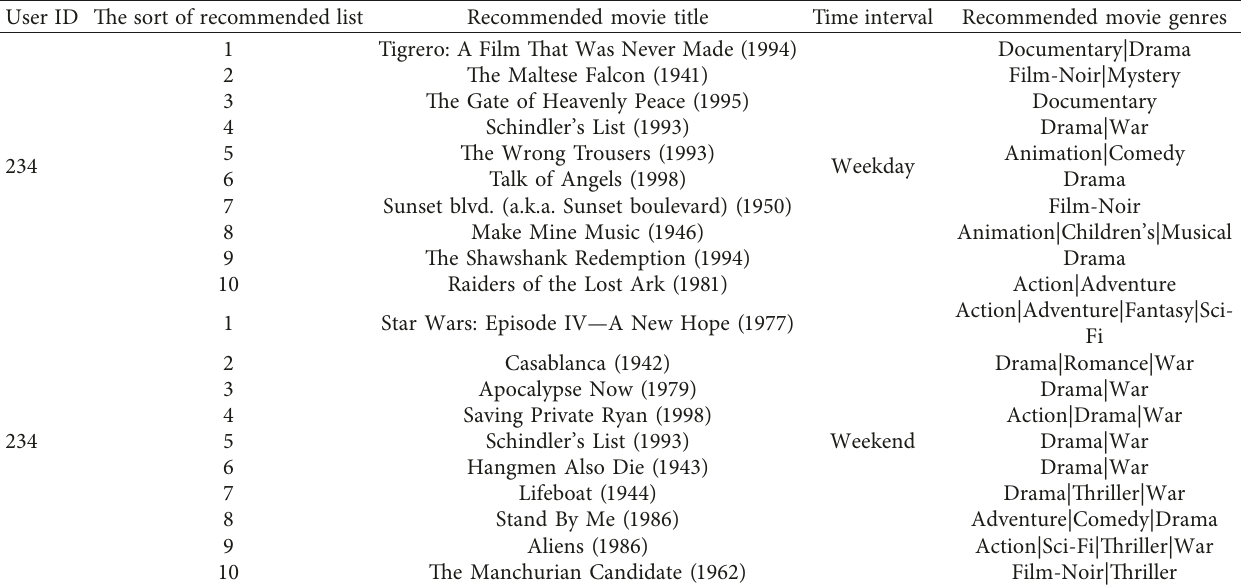
Table 3: The example of the recommended movie list of TC-PR. User ID The sort of recommended list